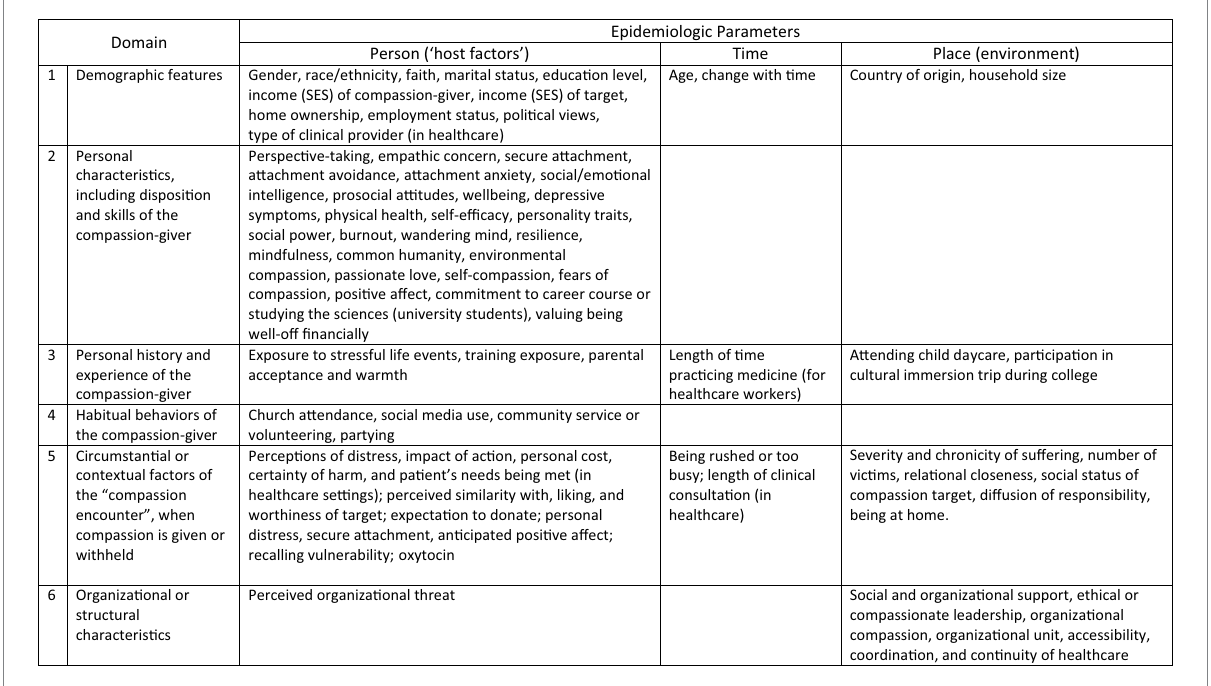
FIGURE 2 Primary alignment of potential risk factor domains with the epidemiologic parameters of person, time, and place. Even though individual potential risk factors are listed only once, some risk factors may be active in multiple domains and affect multiple parameters, e.g., environmental disasters are stressful personal life events. Risk factors refer to the compassion-giver unless otherwise